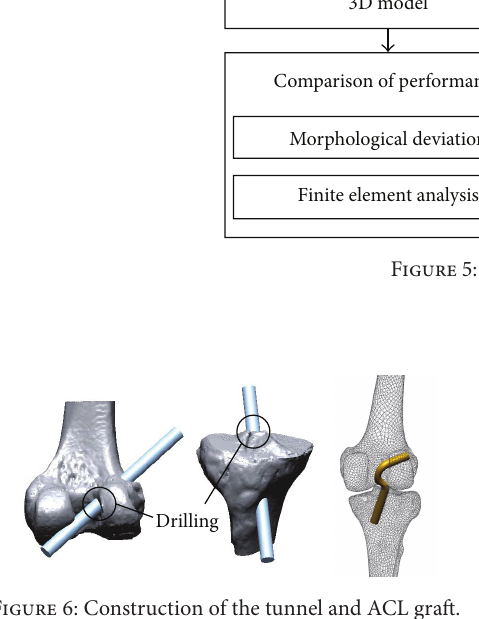
center of rotation. To overcome this difficulty, knee joint angle trajectories were mapped by imaging them in several positions while the experimental subject was executing knee movements. The simulations of the reconstructed models were then compared using the images obtained from four different angles (0 ∘ , 45 ∘ , 90 ∘ , and 135 ∘ ) and the locations of the femur in each angle were superimposed based on the